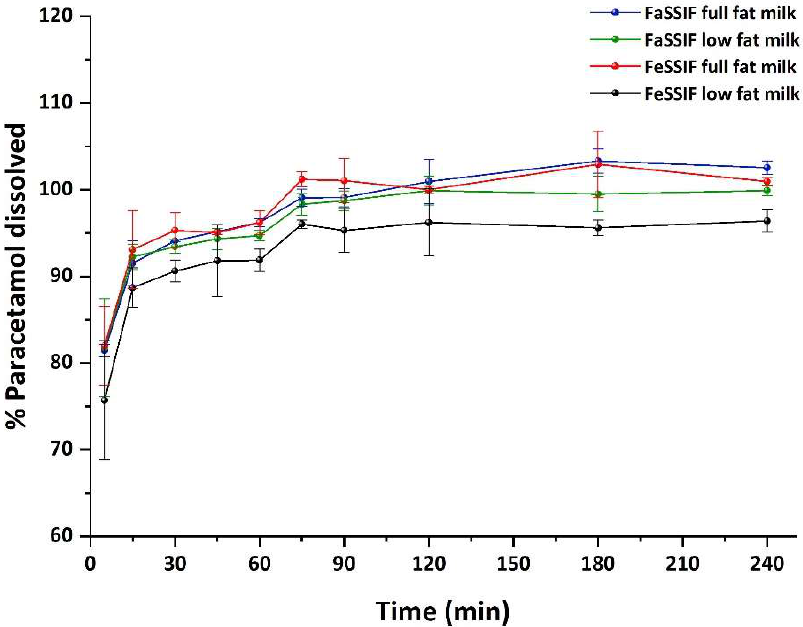
Figure 5. Dissolution profile of paracetamol-loaded cereal following mixing with full-fat (3.5%, blue and red lines) or low-fat (1.5%, green and black lines) milk under fasted-state gastric conditions (FaSSGF) followed by fasted-state (FaSSIF) or fed-state (FeSSIF) intestinal conditions at 37 °C ( n = 3, ±S.D.). The red vertical line shows the time-point of medium change (60 min) (adapted from [7]). Approximately 81% of paracetamol was dissolved within the first 5 min in FaSSGF, achieving total drug dissolution in 15 min after a medium change to FeSSIF or FaSSIF. No statistically significant differences were observed in the dissolution profiles of paraceta- mol in the presence of either low-fat or full-fat milk and in fed-state or fasted conditions. Overlaid chromatograms of the HPLC determination of PAR in a representative sam- ple set are illustrated in Figure 6.